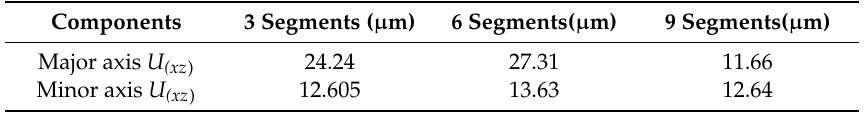
Figure 7. Summarized results of amplitude-frequency characteristic with different segmentation of electrode: ( a ) displacement amplitude in x direction; ( b ) displacement amplitude in y direction; ( c ) displacement amplitude in z direction. Table 3. Dimensions of ellipses major and minor axes.